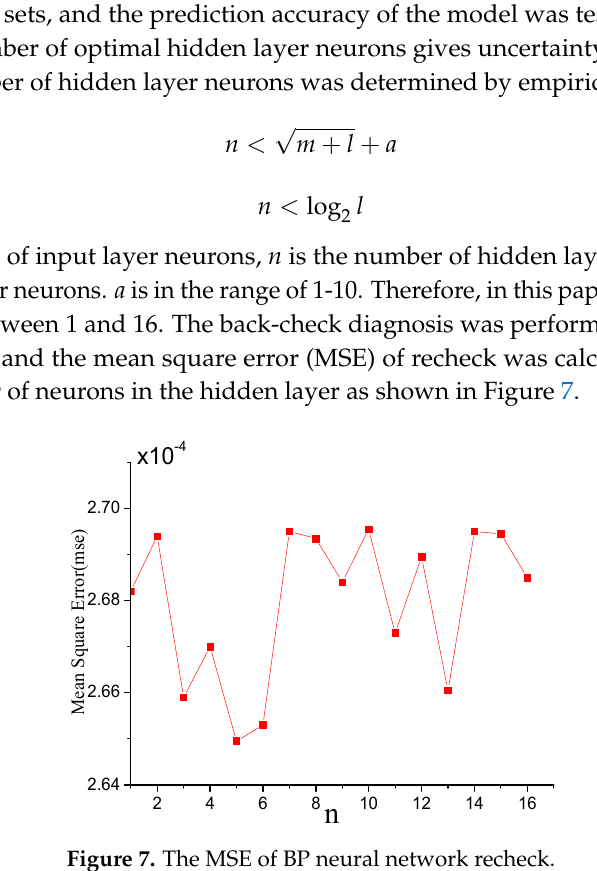
Figure 7. The MSE of BP neural network recheck.